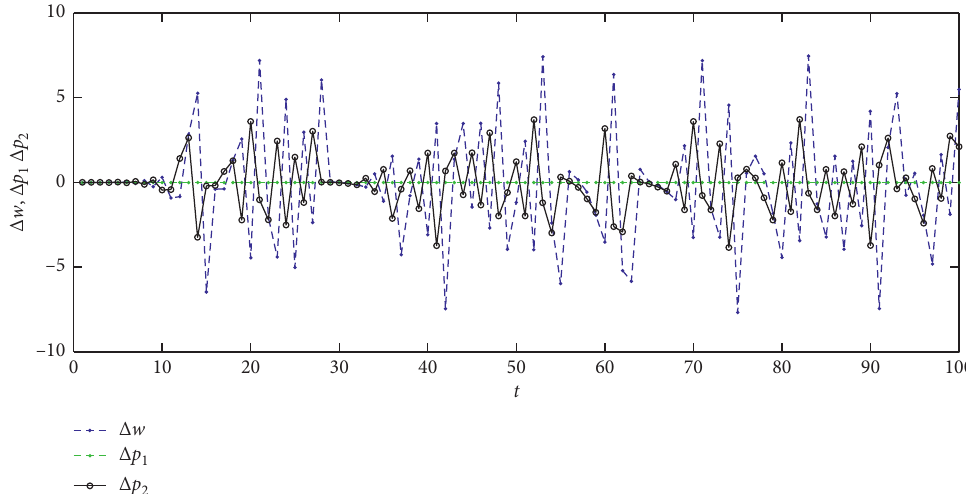
Figure 25: The sensitivity to initial value when ( w, p